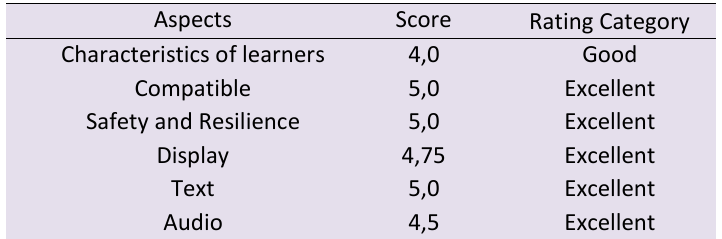
Table 3. Score Results Per Expert Aspect Mehe